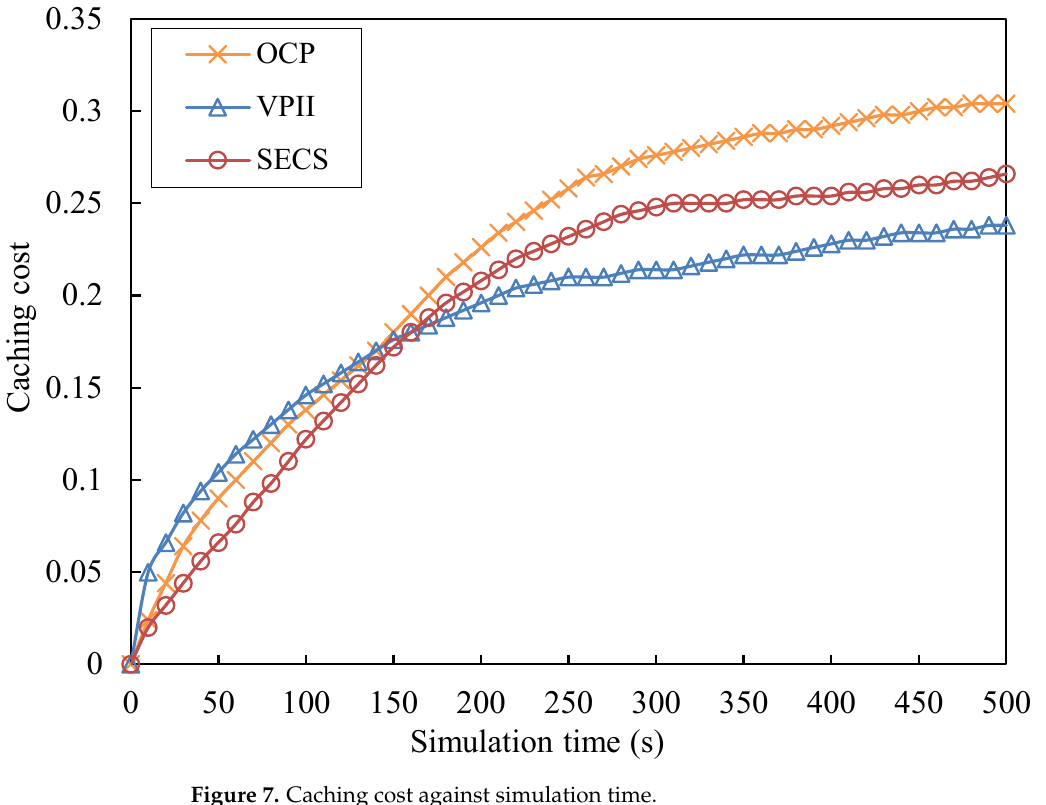
Figure 7. Caching cost against simulation time.